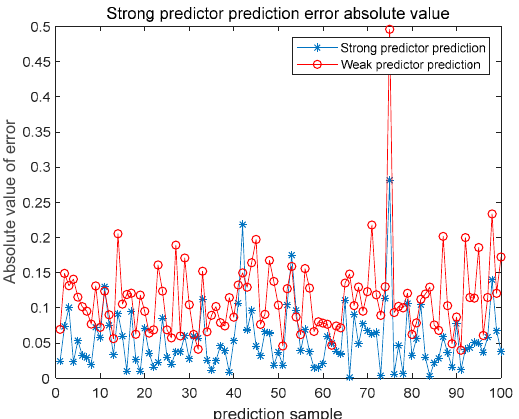
Figure 3. Strong predictor prediction error absolute value.